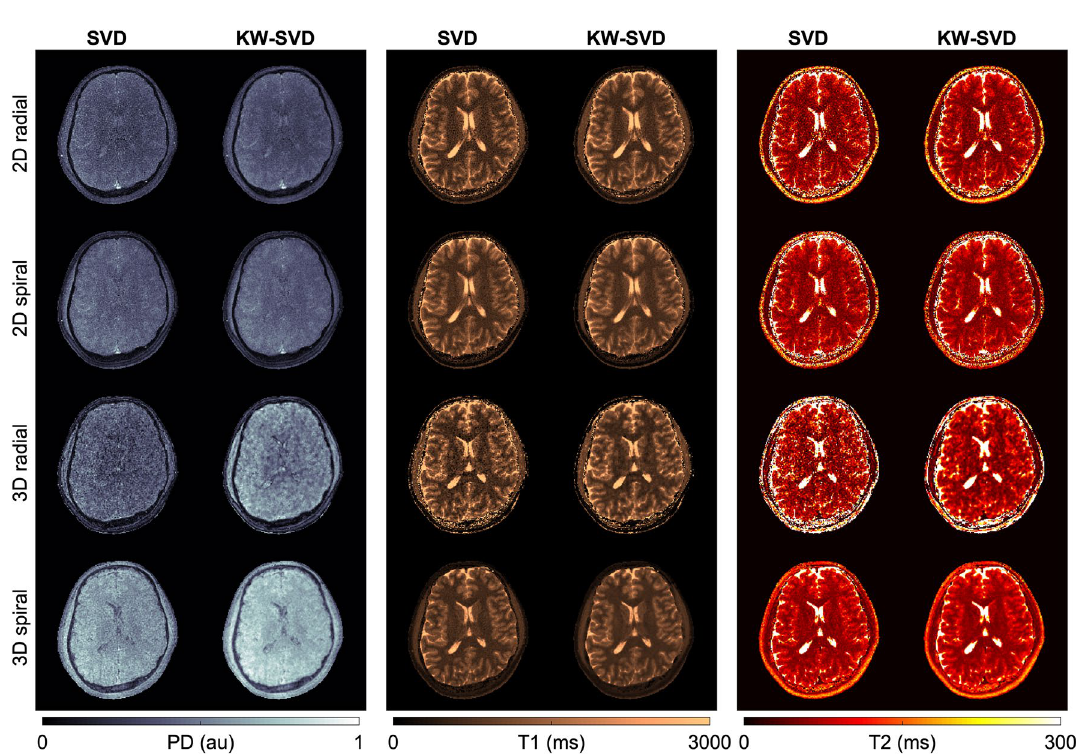
Figure 7. Readout trajectories and reconstruction comparison. A comparison of the different readout trajectories evidences that, while all could be used multiparametric mapping, 3D radials suffer from larger undersampling artifacts. Moreover, view-sharing improves spatial consistency without impacting parameter